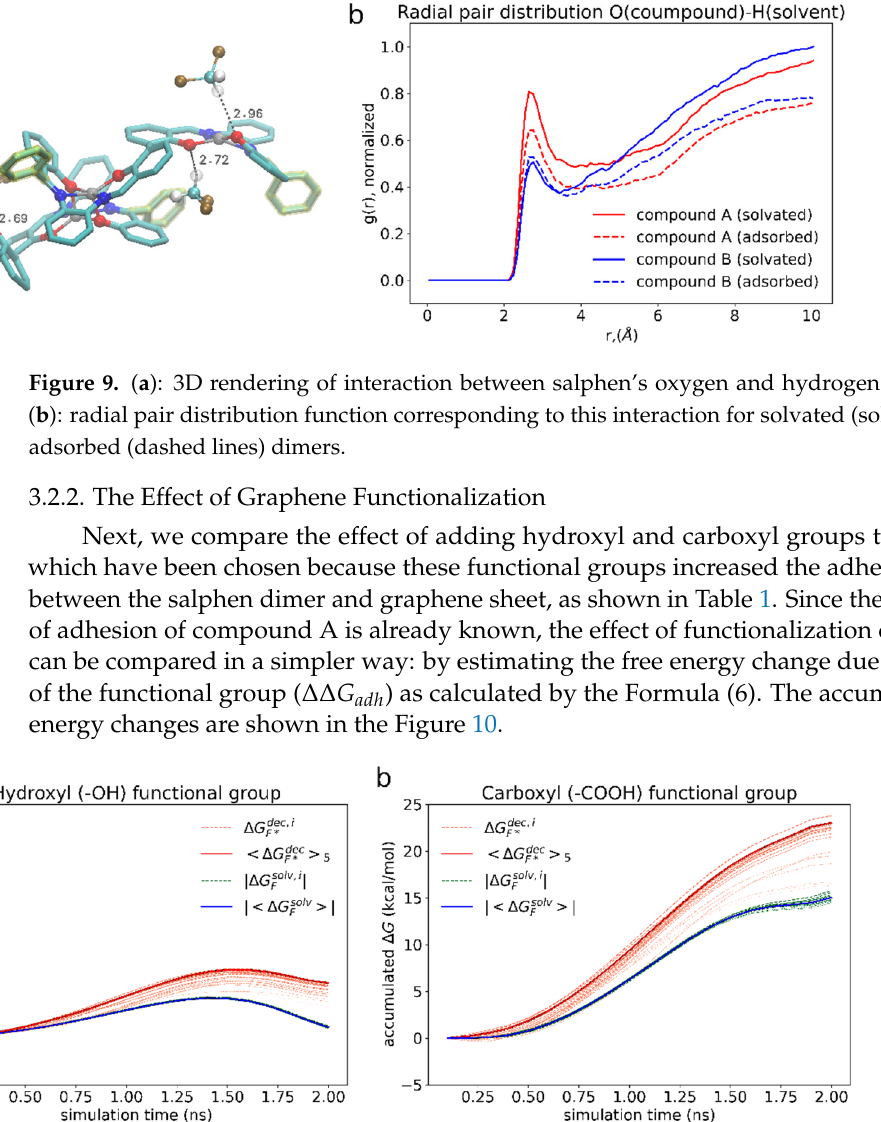
Figure 10. Accumulated free energy change during the decoupling (orange) and immersion (green) of the hydroxyl ( a ) and carboxyl ( b ) functional groups. The intensity of the color highlights how close the final free energy change during a particular simulation is to the maximum value over the whole set. Blue and red solid lines represent the average free energy change for the cases of solvated and adsorbed dimers (of N = 5 most favorable simulations) correspondingly. For the ease of visualization and comparison, absolute values are drawn for the solvation free energy of the functional groups.